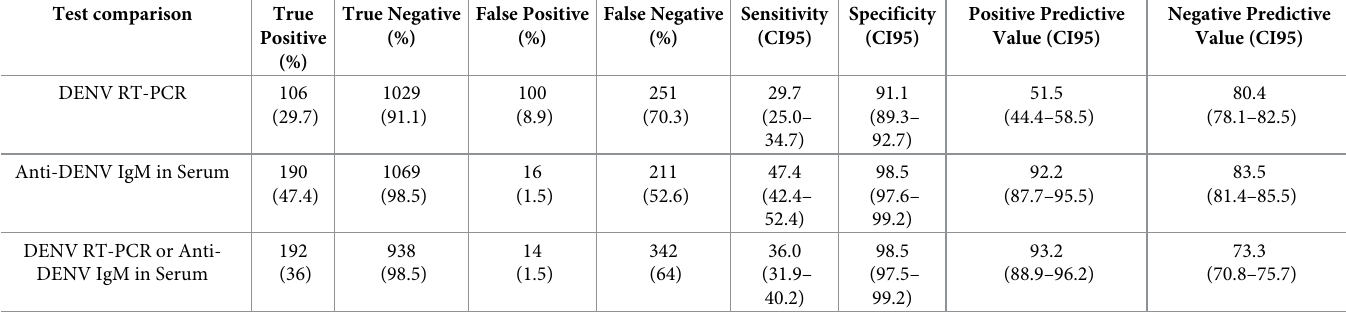
Table 2. Diagnostic testing comparisons. Sensitivity and specificity of urine anti-DENV IgM by test type in serum. Test comparison